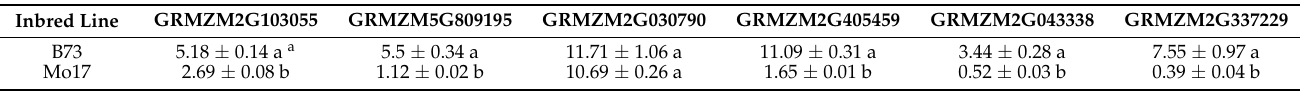
Table 2. Effect of deep sowing on candidate-gene expression in different deep-sowing-tolerant maize inbred